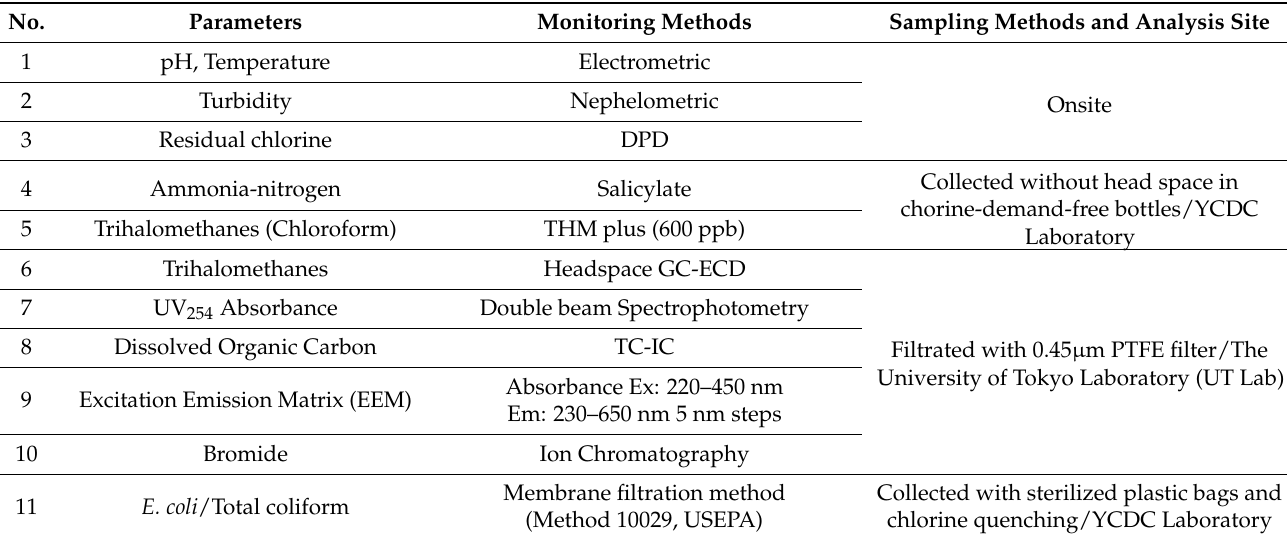
Table 3. Monitoring parameters and analysis